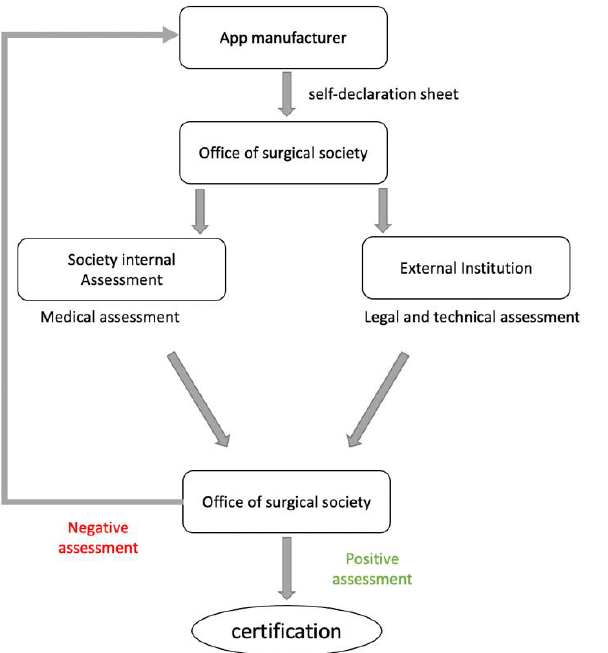
Figure 2. Flowchart depicting the proposed algorithm for the rating of mobile apps performed by orthopedic societies.